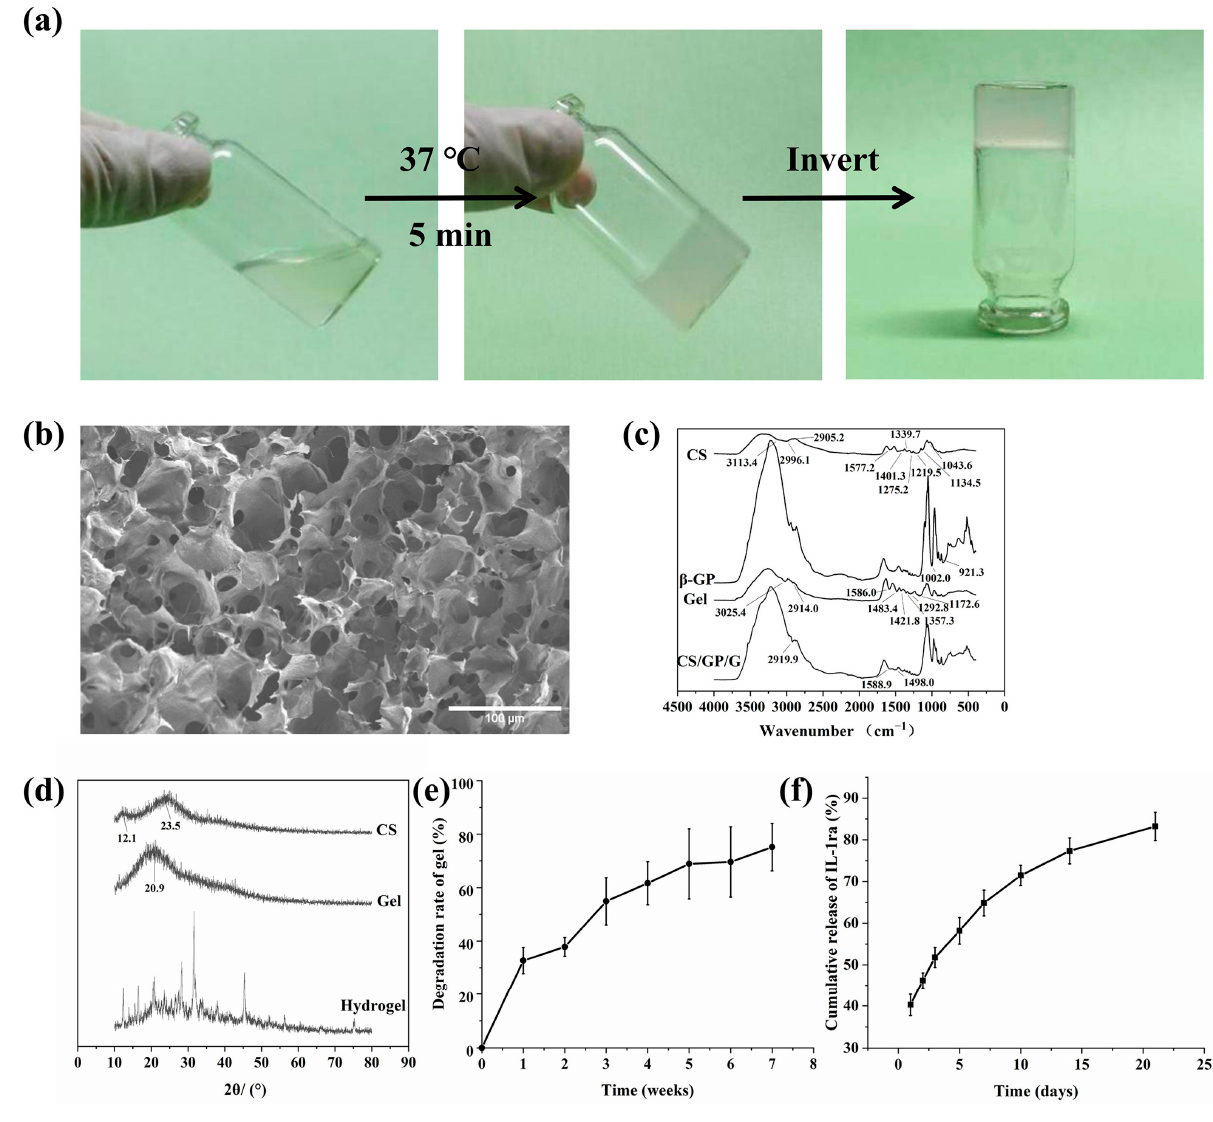
Figure 1. Characterizations of CS/ β -GP/gelatin thermosensitive hydrogels. ( a ) Image of CS/ β - GP/gelatin mixed solution transformed into hydrogel after 5 min at 37 °C. ( b ) Optical microscope images of chitosan/ β -GP/gelatin thermosensitive hydrogel. ( c ) FT-IR spectra for chitosan, β -GP, gelatin, and chitosan/ β -GP/gelatin thermosensitive hydrogel. ( d ) XRD patterns of chitosan, gelatin, and chitosan/ β -GP/gelatin thermosensitive hydrogel. ( e ) Degradation percentage curve of CS/ β - GP/gelatin hydrogel. ( f ) The release percentage curve of IL-1ra from CS/ β -GP/gelatin hydrogel.